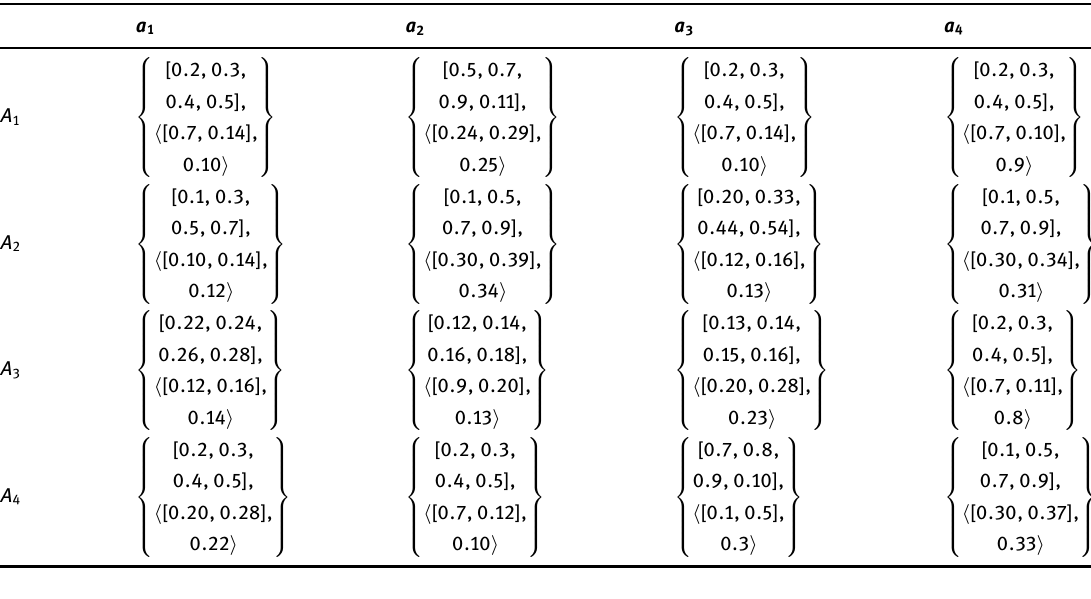
Table 1: Decision Matrix Given by Expert p 1 .